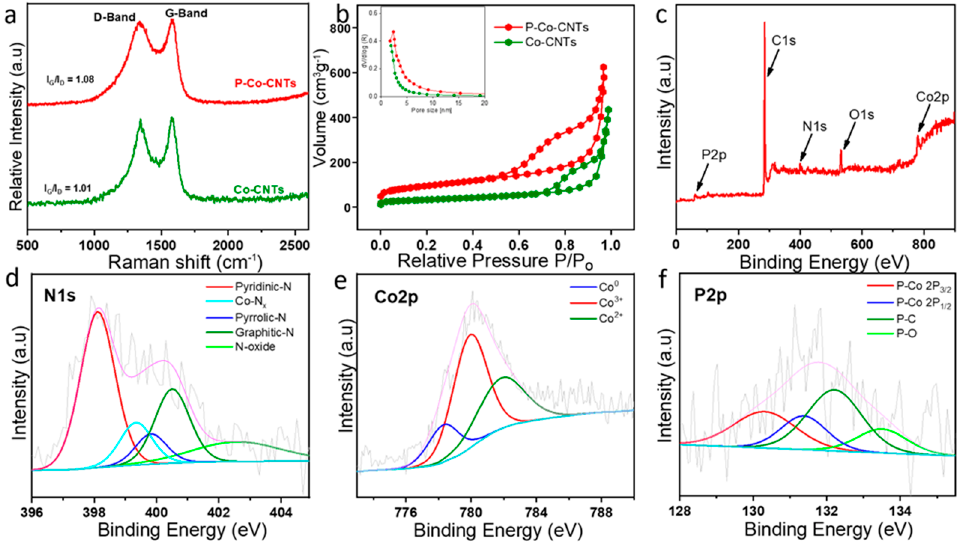
Figure 3. ( a ) Raman spectra of P-Co − CNTs and Co − CNTs and ( b ) N 2 adsorption–desorption isotherms (inset: pore-size distribution) of Co-CNTs and P-Co-CNTs; ( c ) XPS survey analysis of Co − CNTs; high-resolution XPS spectra of P-Co-CNTs; ( d ) N 1s; ( e ) Co 2p; ( f ) P 2p.